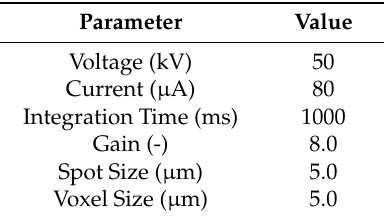
Table 1. Zeiss Metrotom ® 800 scan parameters.